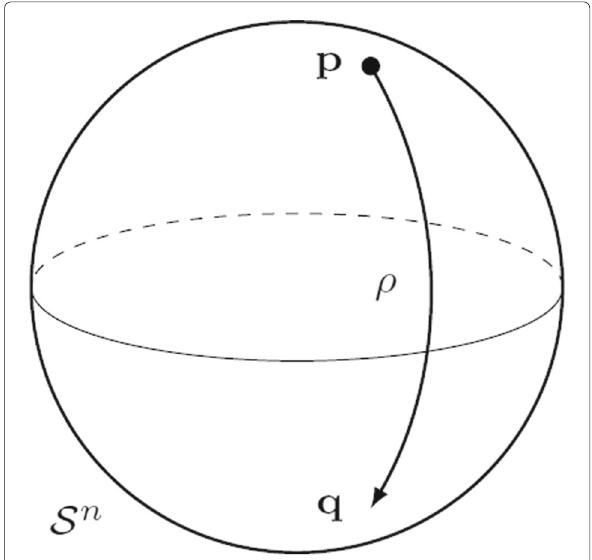
Fig.2 Example of an n -sphere S n ( n = 2) embedded in an ( n + 1)-D space R n + 1 . p and q aremanifold points, i.e., p , q ∈ S n . The geodesic